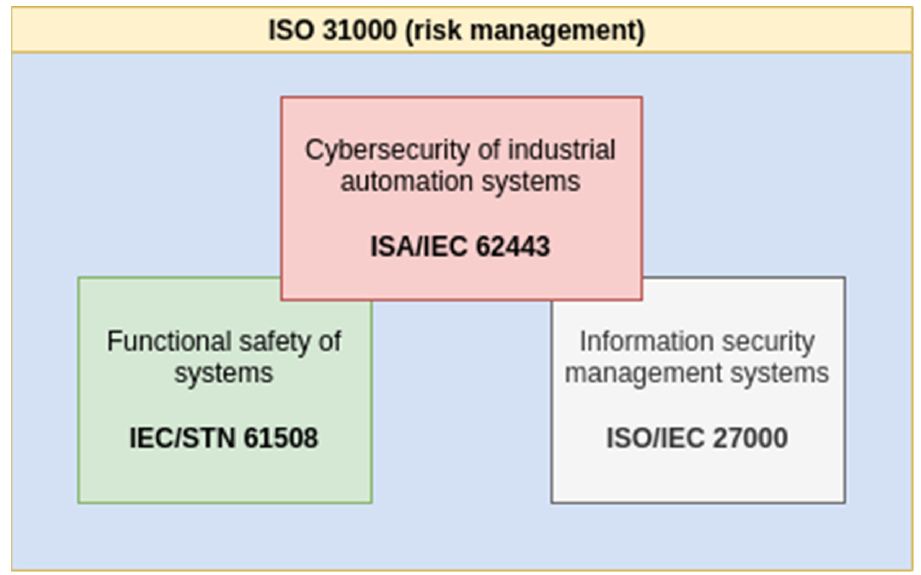
Figure 11. Areas covered by